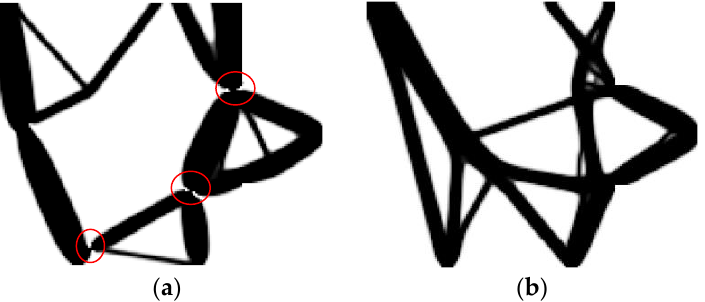
Figure 5. Design results obtained by using optimization models ( a ) Equation (17) and ( b ) Equation (19).